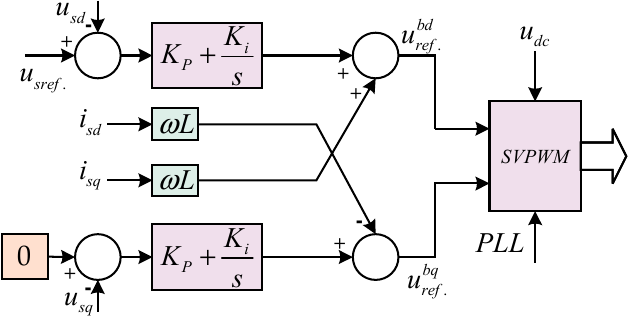
Figure 11. The decoupling control strategy in dq reference frame.